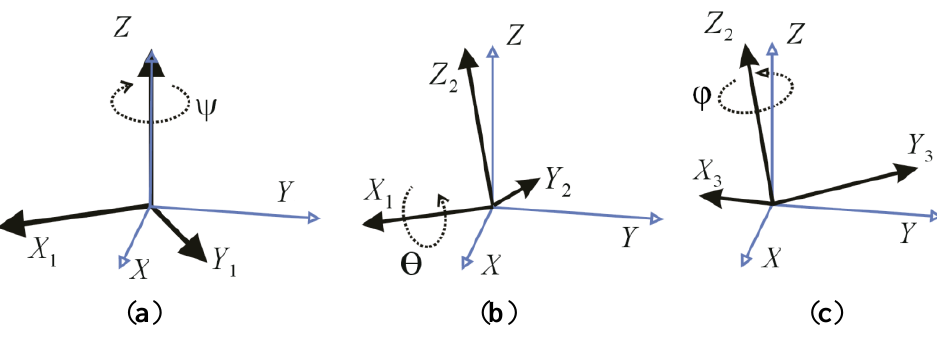
Figure 3. ( a ) Euler angles ( ψ , θ , φ ): ( a ) ψ defines the first rotation about the z -axis